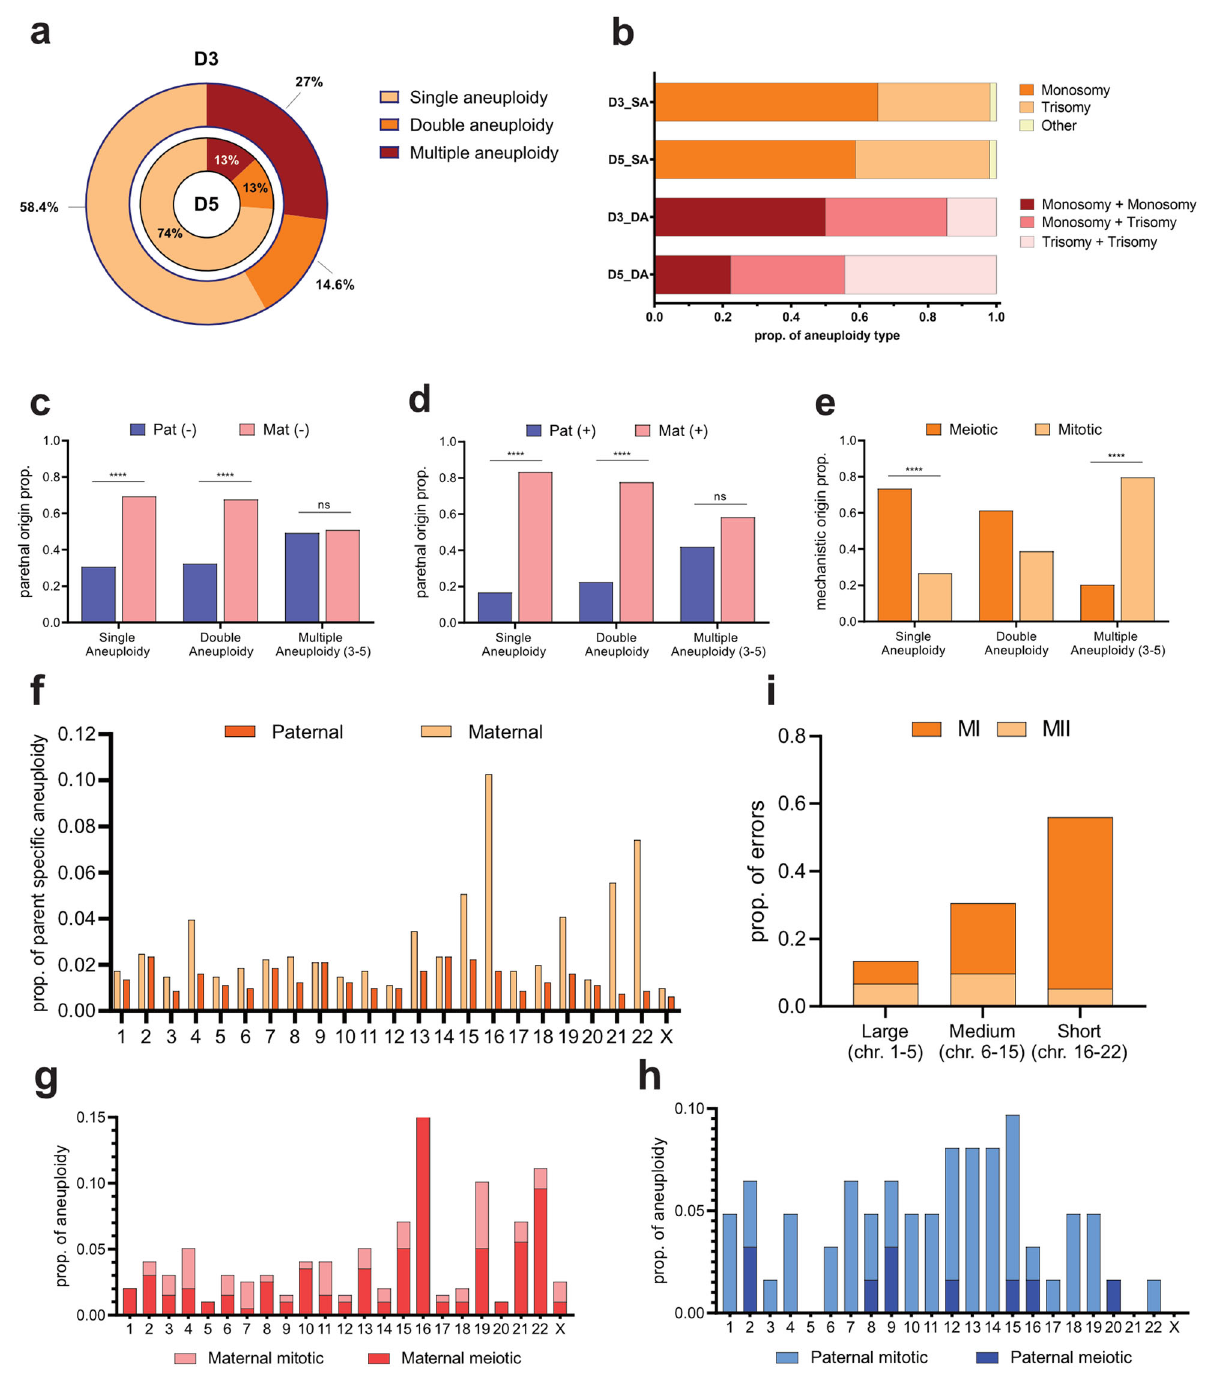
Fig. 2 Origin and chromosome-speci fi c rate of aneuploidy in blastomeres of human IVF embryos. a Frequency of single, double and multiple (3 – 23 chromosomes affected) aneuploidy in cleavage embryos (D3) and blastocysts (D5) ( n = 712 and n = 69, respectively). b Proportion of aneuploidy types in single (SA) and double (DA) aneuploidy in cleavage embryos (D3, n = 416 and 104, respectively) and blastocysts (D5, n = 53 and 9, respectively). c Parental origin of monosomy in cleavage embryos; n = 274, 140, and 122 for single, double and multiple (3 – 5 chromosomes affected) aneuploidy, respectively (two-tailed binomial test, **** P < 0.0001). Parental ( d ) and mechanistic ( e ) origin of trisomy in cleavage embryos; n = 134, 68, and 67 for single, double and multiple (3 – 5 chromosomes affected) aneuploidy, respectively (two- tailed binomial test, **** P < 0.0001). f Rate and distribution of paternal and maternal aneuploidy ( n = 805) across the genome in cleavage embryos. Rate and mechanistic origin of maternal ( n = 199) ( g ) and paternal ( n = 62) ( h ) trisomy across the genome in cleavage embryos. i Association between maternal meiotic error type and chromosome classi fi cation by length ( n = 139, P < 0.0001, χ ² for